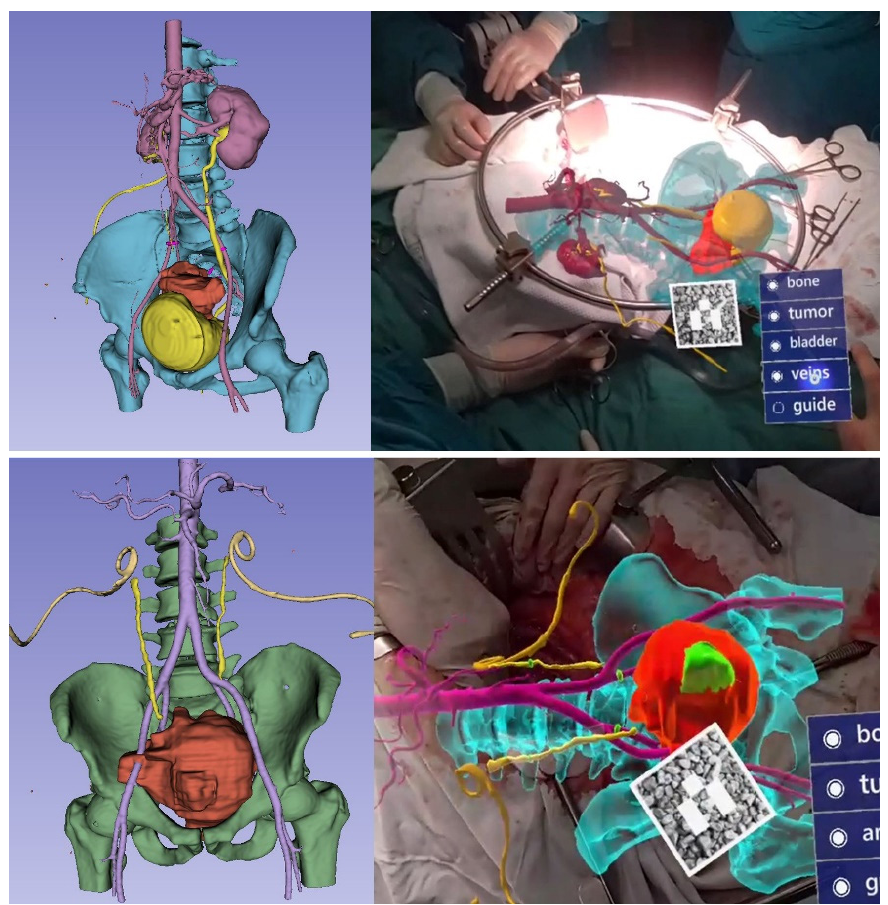
Figure 11. 3D model of the reconstruction of the anatomy of the patient and its overlay during the operation. According to Table 2, patient 3 is above, patient 1 is